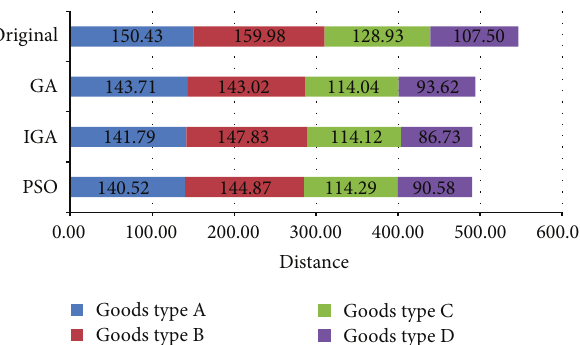
Figure 17: The Gantt chart for different travelled distances under Case